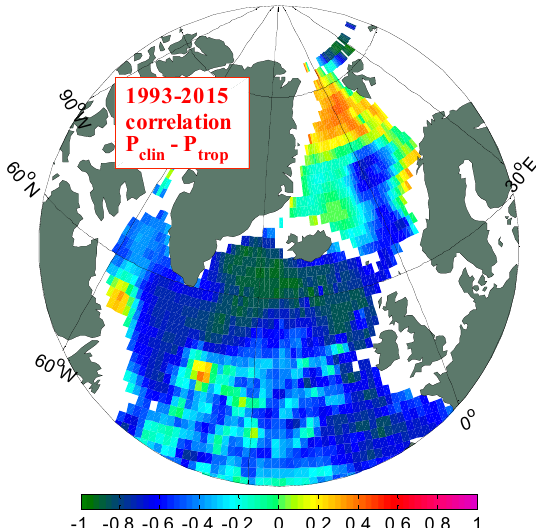
Figure 9. The correlation between P clin and P trop .